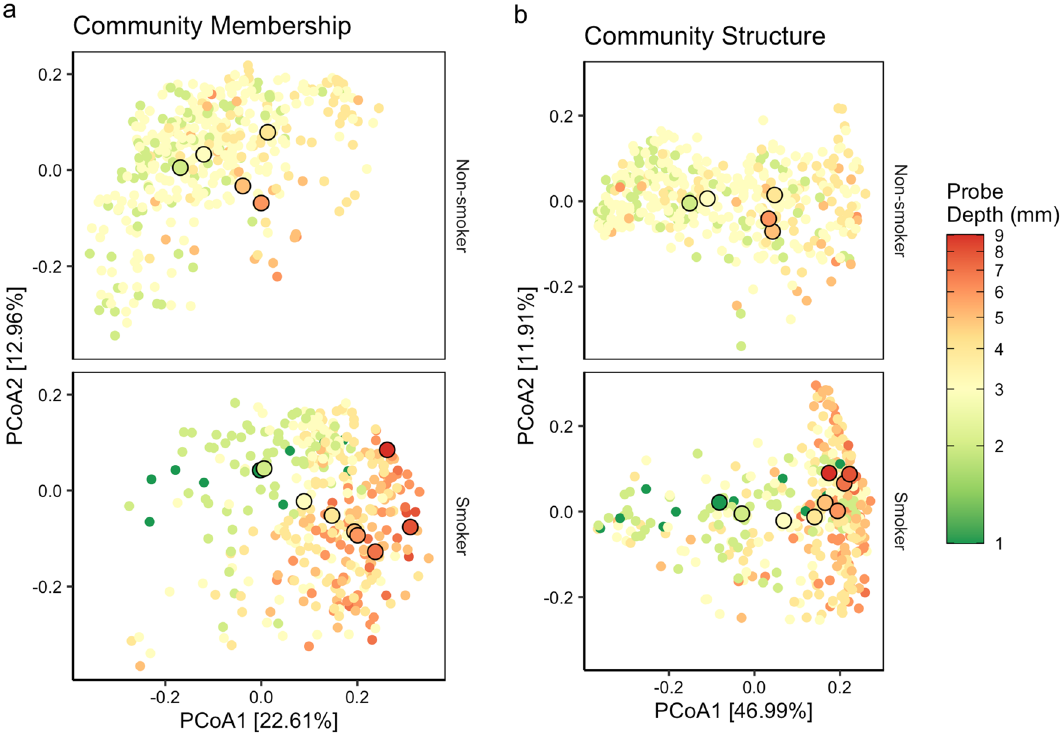
Figure 2. Subgingival microbiomes according probing depth and smoking status based on UniFrac distances. Principal coordinates analysis on ( a ) unweighted and ( b ) weighted UniFrac distances. Non-smokers (top) and smokers (bottom) are showed separately for clarity but are in the same frame for direct comparison. Each point is a single subgingival sample, and the color shows the probing depth of the subgingival site. The centroid for a given probing depth is shown by an outlined circle. For a given probing depth (e.g. green outlined circles), the centroids of smoker sites are shifted to the right compared to the centroids of non-smokers sites. In addition, the centroids of shallow sites of smokers (i.e. green or yellow outlined circles) overlap with the centroids of deeper sites in non-smokers (i.e. orange or red outlined circles), suggesting subgingival dysbiosis in smokers at equal probing depths.